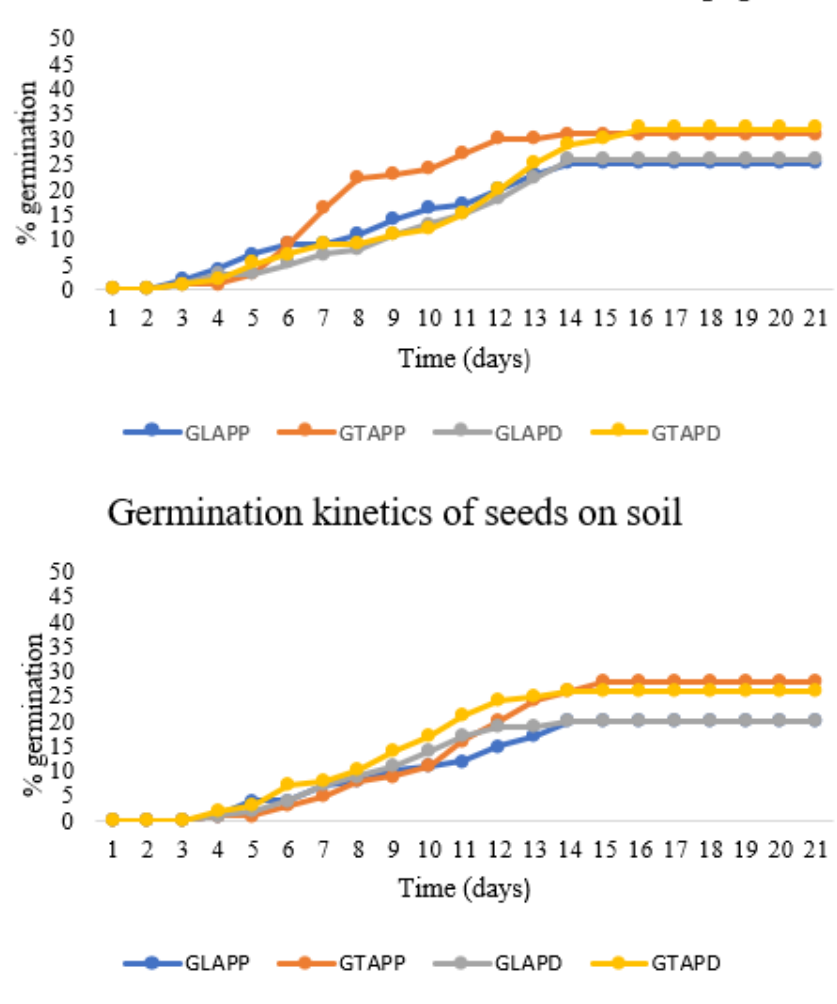
Figure 2. Germination kinetics of the two studied varieties on soil and filter paper (GLAPP: periphe- ral seeds of A.P var. pyrethrum ; GTAPP: central seeds of A.P var. pyrethrum ; GLAPD: peripheral seeds of A.P var. depressus ; GTAPD: central seeds of A.P var. depressus ).